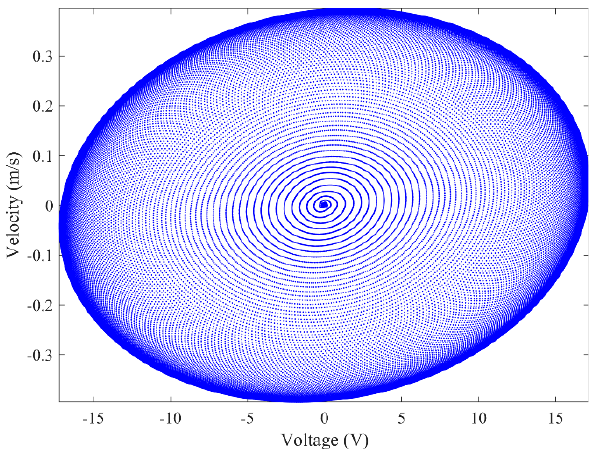
Figure 10. Phase portrait (limit cycle oscillation) ( U = 1.8 m/s).